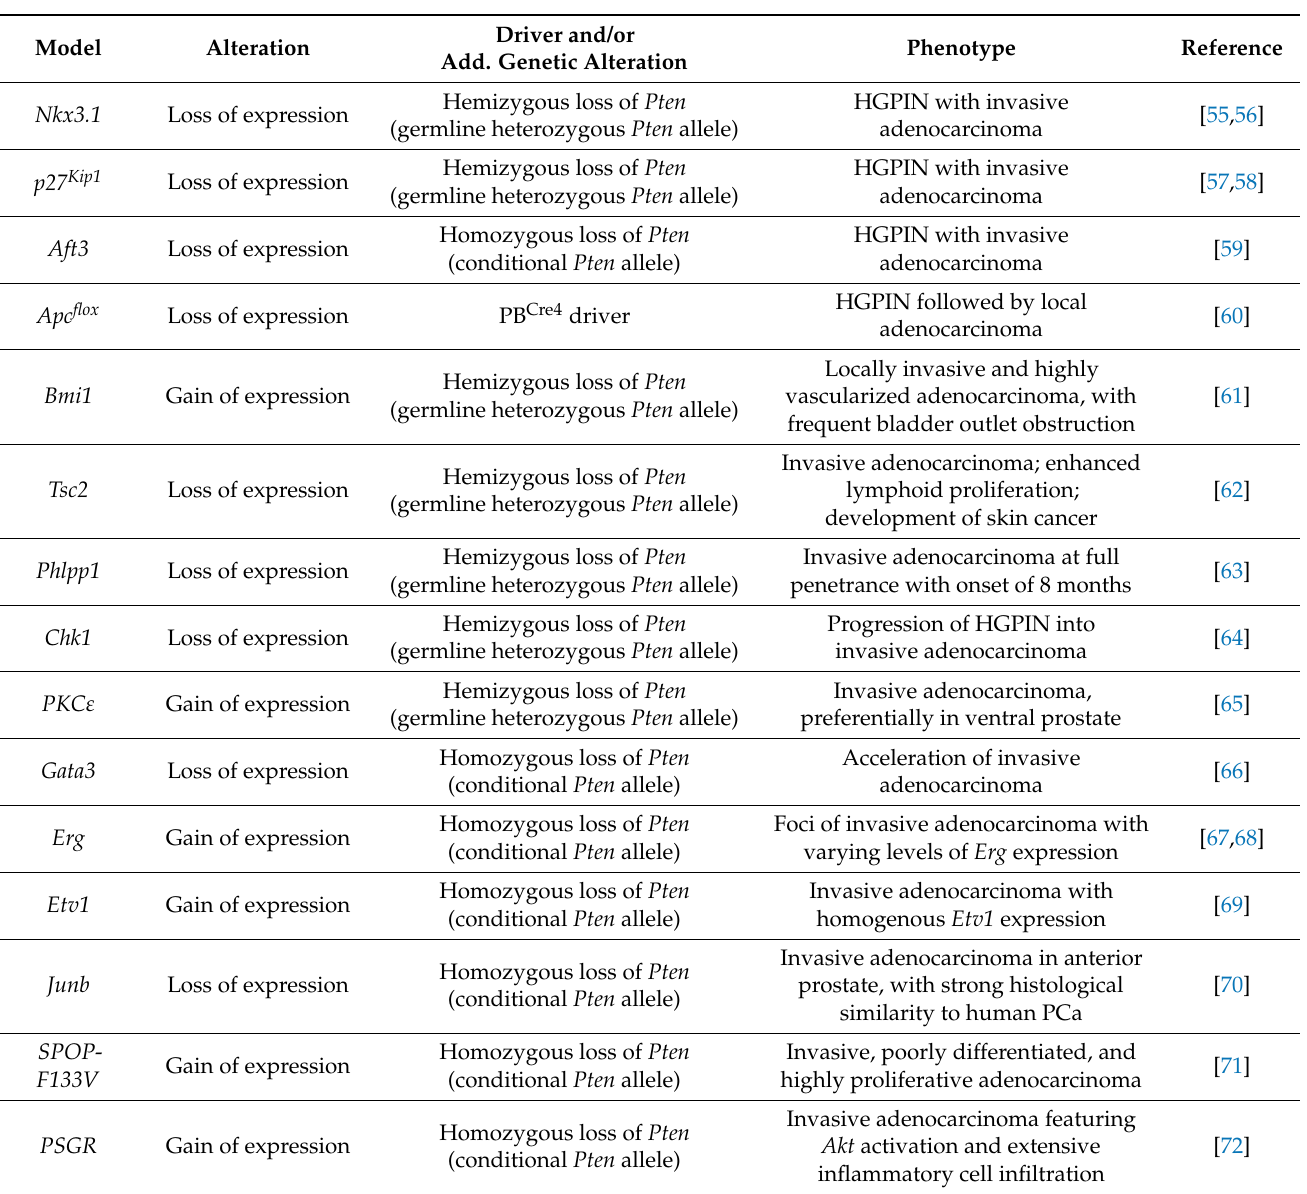
Table 5. PCa models in which adenocarcinoma is